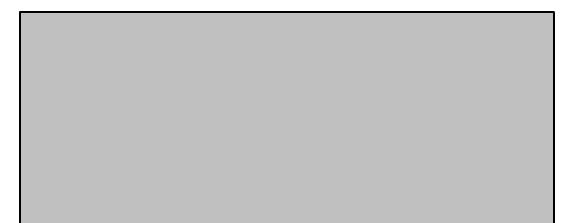
Table VII : HIV status according to mode of substance